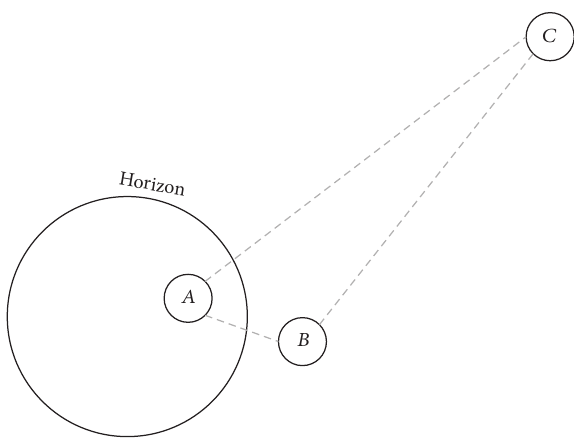
Figure 2: Systems involved in the firewall argument, with dotted lines showing the entanglement required by horizon complemen-